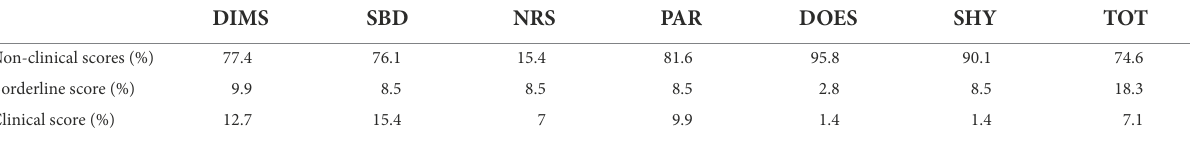
TABLE 1 Distribution of sleep disturbances in preschool-aged children with